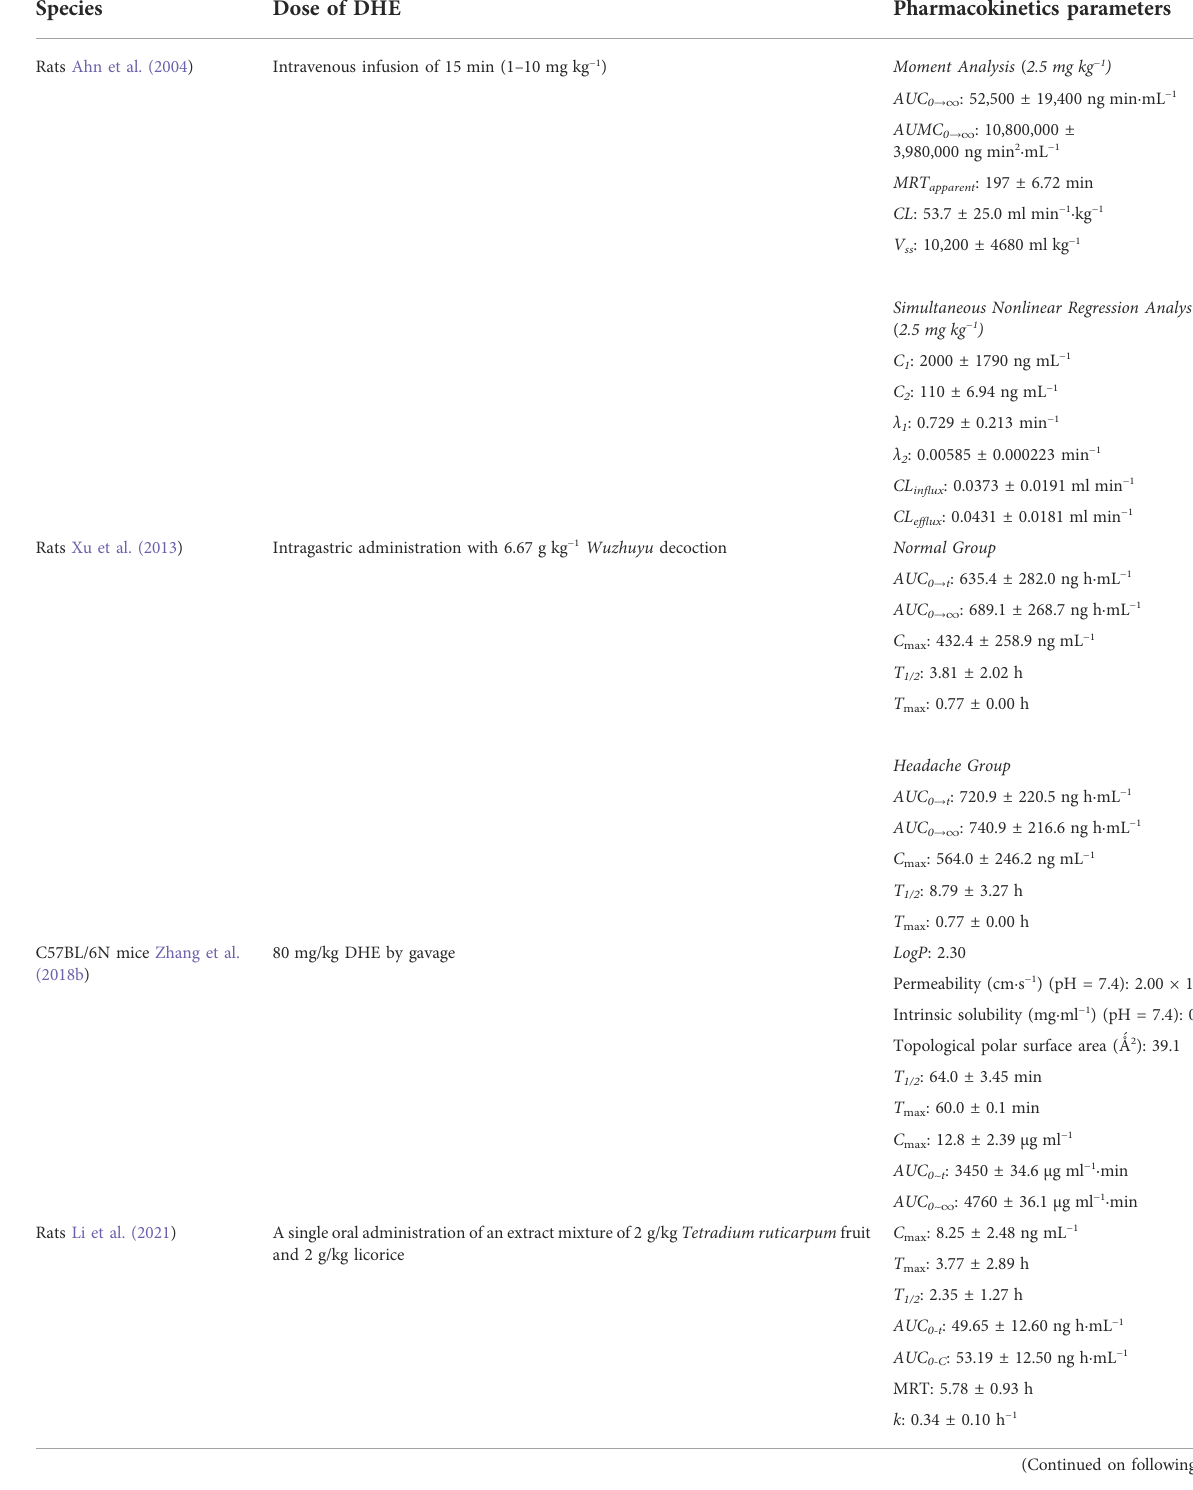
TABLE 1 Pharmacokinetic parameters of